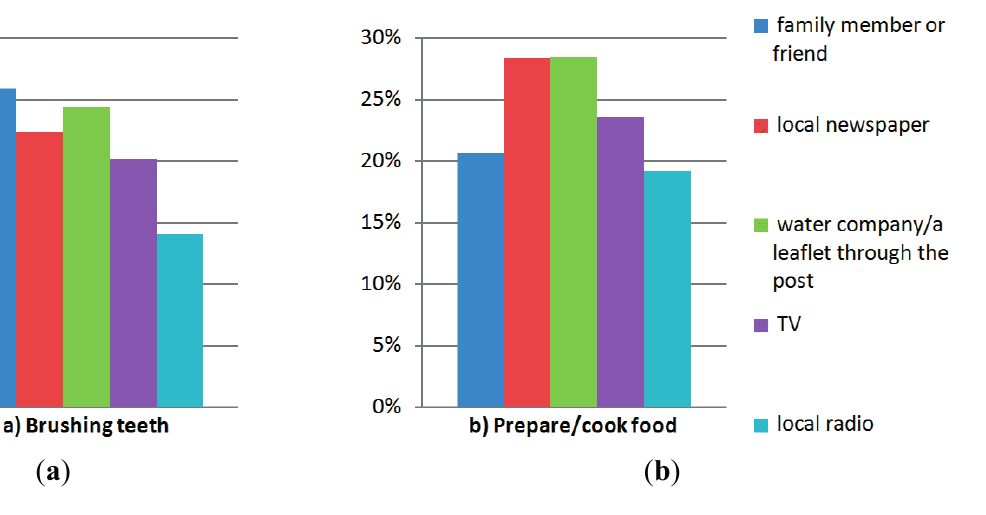
Figure 1. Percentage of information source users who did not comply with the advice ( a ) not to brush teeth and ( b ) not to use for preparation/cooking of food with unboiled tap